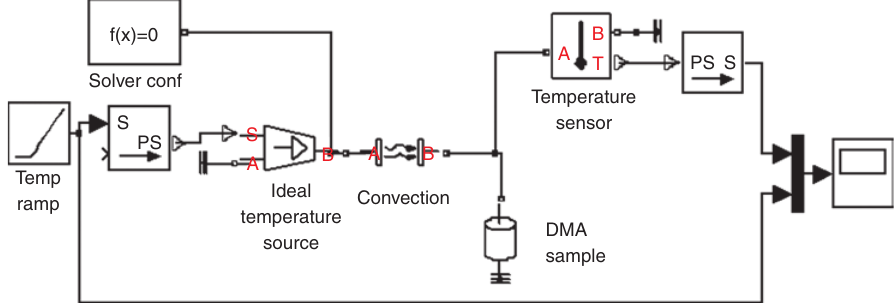
Figure 1: The Matlab/Simulink model for considering of convection phenomena.